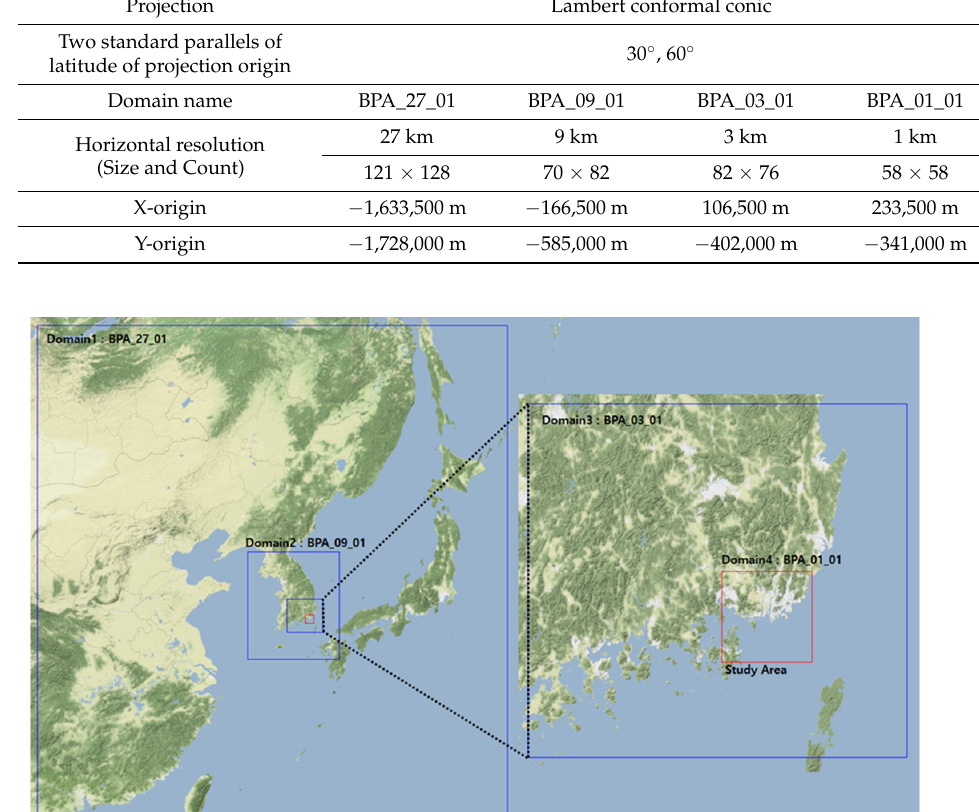
Figure 2. Domain area for PM 2.5 prediction. (Red box: Research